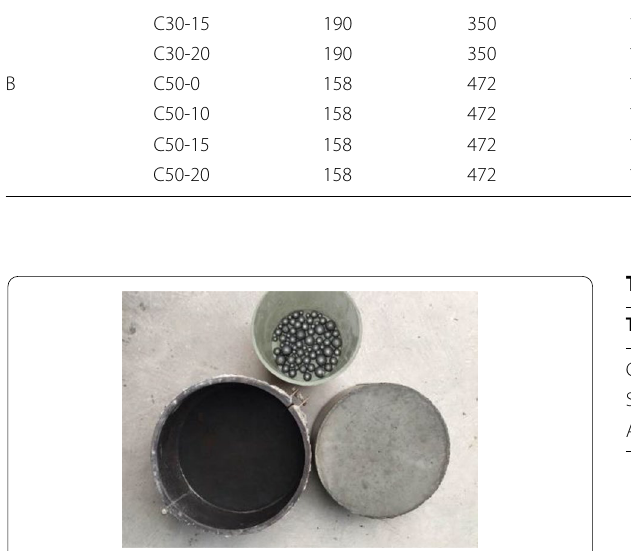
Fig. 3 Concrete specimen and steel balls